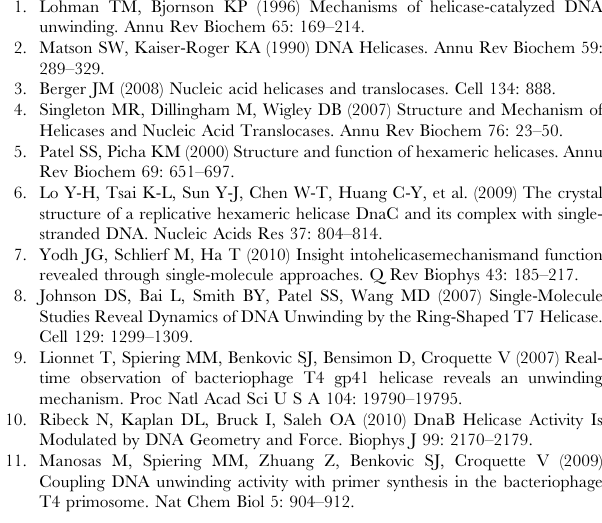
amounts of purified proteins as indicated (0.1, 0.15, 0.25, 0.5, 1, 2 and 4 m M). To normalize these values, the percentage of product was calculated using the equation, %Unwound = (%U S – %U 0 )/ (%U 100 – %U 0 ) (detail in materials and methods). Two indepen- u C dent experiments are shown here and are represented as red and blue lines (right panel). (TIF) Figure S5 The rate of ATP hydrolysis of Gk DnaC under different molar ratio of protein to ssDNA. The rate of ATP hydrolysis is proportional to the rate of the decrease in absorbance at OD 340 , and it can be calculated according to the formula: 2 1 ) 6 9820 = rate of ATPase ( m M/min). Reactions D A 340 /time (s were initiated by the addition of 1 m M Gk DnaC WT (per monomer) into the mixture in the presence of 15-mer single- stranded oligo-dT DNA (50 nM or 10 m M). Two independent experiments are shown here in different molar ratio system. (TIF) Figure S6 Unwinding and ATPase activity of Gk DnaC were affected when Gk DnaC was associated with primosomal protein. A. The effect of primosomal protein on helicase unwinding efficiency. The abscissa shows varying enzyme and complex formation, which is correlated to the unwinding efficiency (fold) shown on the top of each bar. B. The effect of primosomal protein on ATP hydrolysis of Gk DnaC. The rate of ATP hydrolysis was calculated from the rate of change in absorbance at 340 nm due to oxidation of NADH. Data represent the average of three independent experiments.